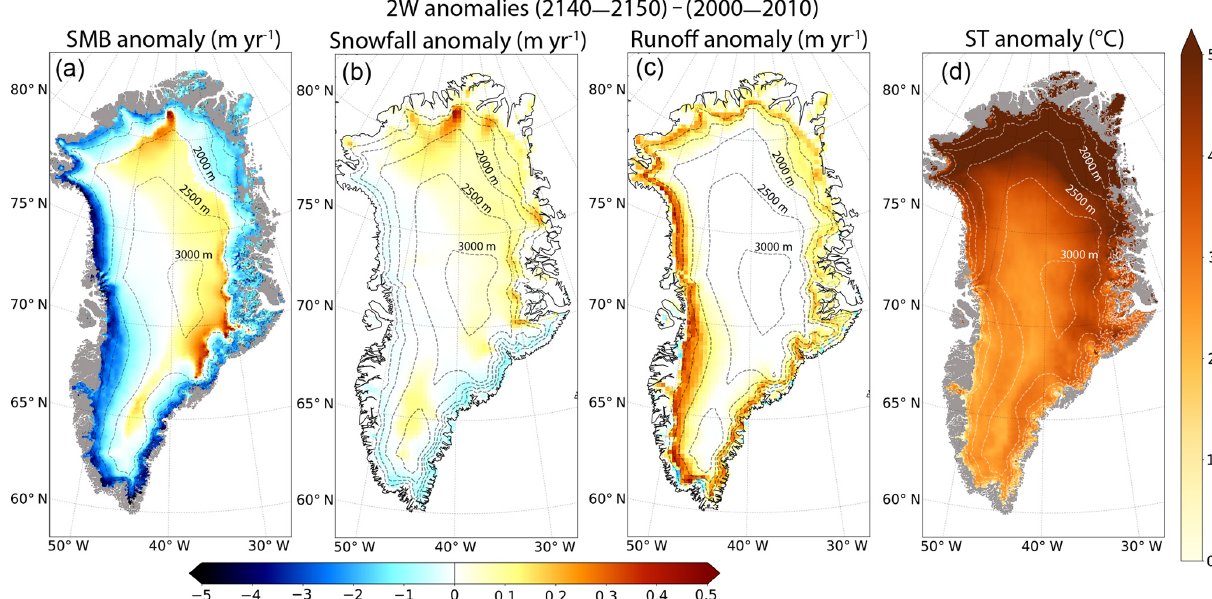
Figure 2. Anomalies of (a) mean annual surface mass balance in myr − 1 , (b) annual snowfall in myr − 1 , (c) annual runoff in myr − 1 and (d) mean annual surface temperature (in ◦ C). These anomalies are given between the last (2140–2150) and the first (2000–2010) decade of the 2W experiment. Panels (a) and (d) are computed on the GRISLI grid and (b) and (c) are given on the MAR grid. The dashed lines correspond to the 500m surface elevation iso-contours for the present-day observed topography. The grey shading represents the non-ice-covered areas. Note for (a) , (b) and (c) that the colour scale is not symmetrical for positive and negative